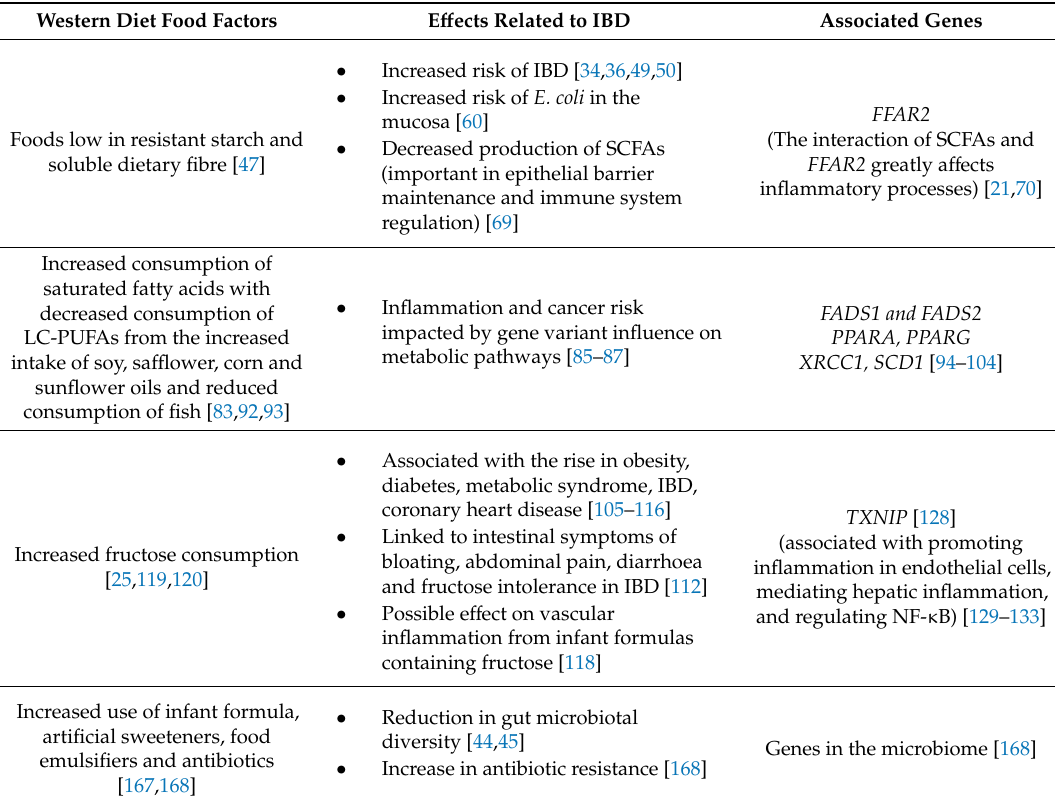
Table 3. Western diet food factors, e ff ects related to IBD and associated genes. LC-PUFA: long-chain polyunsaturated fatty acid; SCFA: short-chain fatty